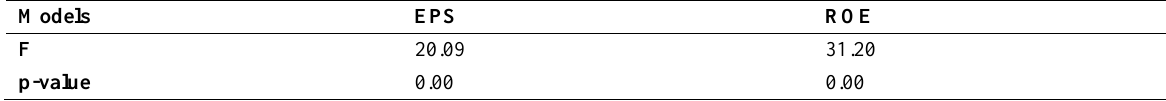
Table-9: Summary of the Ramsey RESET Test for Model Specification